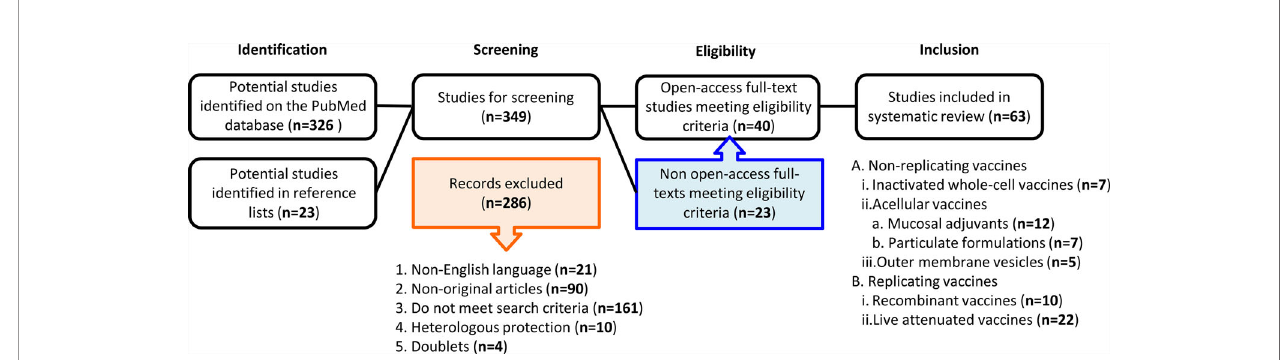
FIGURE 1 | A fl owchart of the methodology used to select the relevant publications. Among the initial total of 349 studies identi fi ed duplicates and articles providing corrections were excluded for the screening. At screening 286 articles were excluded, as they did not ful fi ll our eligibility criteria. Among the remaining 63 articles, 40 were open access, while 23 were not open access. All 63 articles were included in this